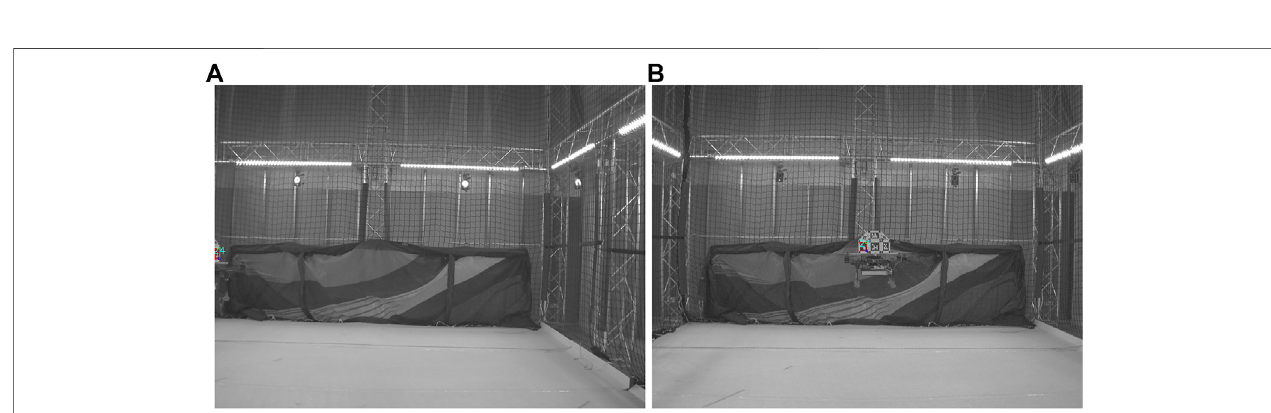
FIGURE 13 | Follower ’ s camera FoV upon loss (A) and reappearance (B) of leader.